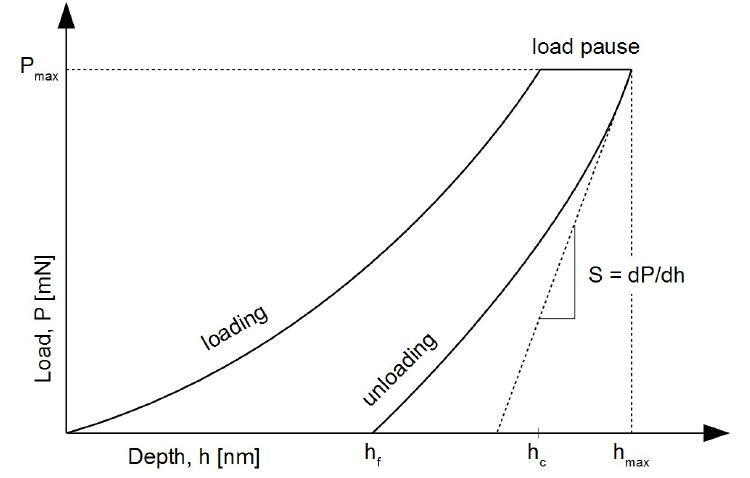
Figure 4. Typical indentation curve – load vs. depth.